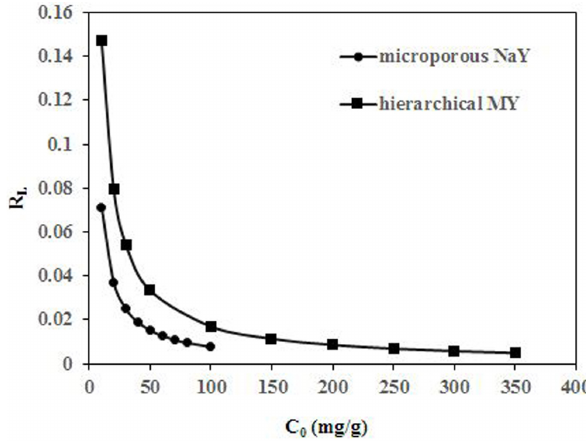
) for microporous NaY L